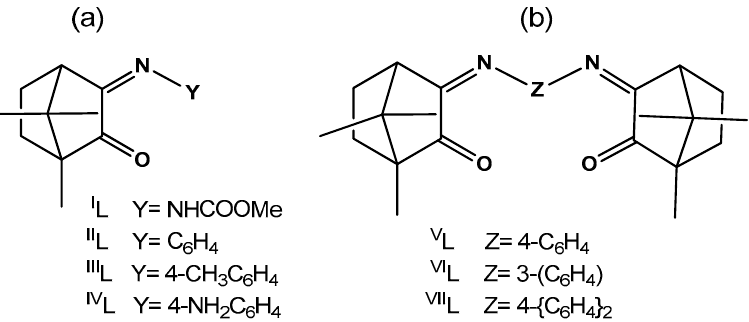
Figure 1. Camphor derivatives used as ligands: ( a ) camphorimine and ( b ) bicamphor type.